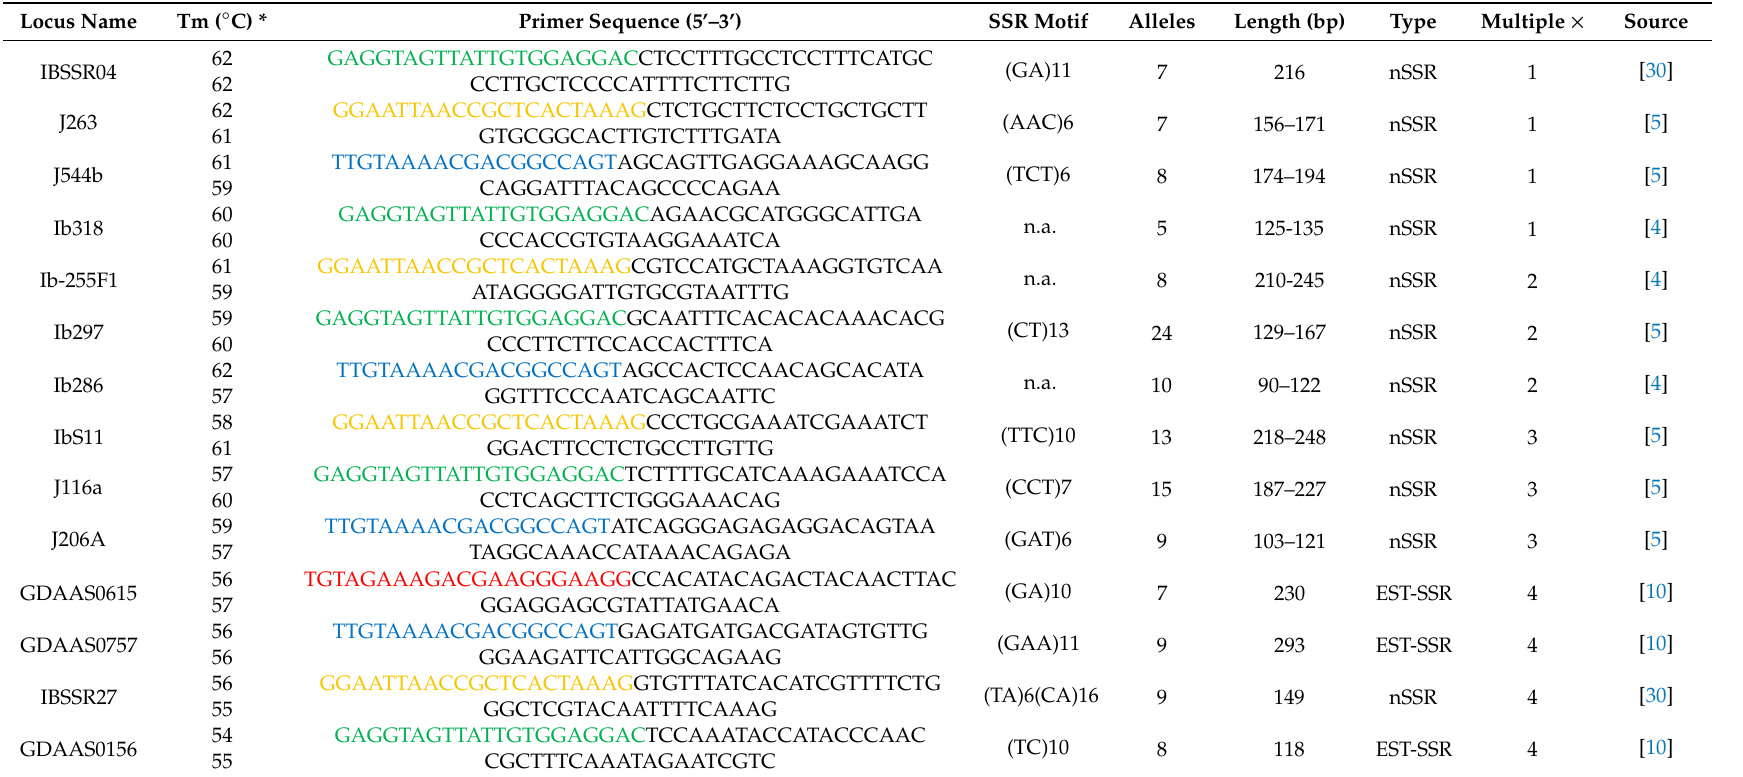
Table 2. List of SSR marker loci used in this study along with their basic information. For each SSR region, locus name, melting temperature (Tm), primer sequences, microsatellite motif, number of alleles according to the reference study, amplicon length in base pairs (bp), microsatellite type (including n SSR = SSR from non-coding regions and EST − SSR = SSR from coding regions), multiplex organization (for the simultaneous run of PCR products from di ff erent SSR marker loci in capillary electrophoresis) and the sources from which the SSR data were obtained are reported. Colored bases at the 5’ end of each forward primer represent four universal sequences (designated as M13, in blue, PAN1, in green, PAN2, in yellow and PAN3, in red) complementary to as many fluorophore-labeled oligonucleotides (fluorophores adopted were 6-FAM, VIC, NED and